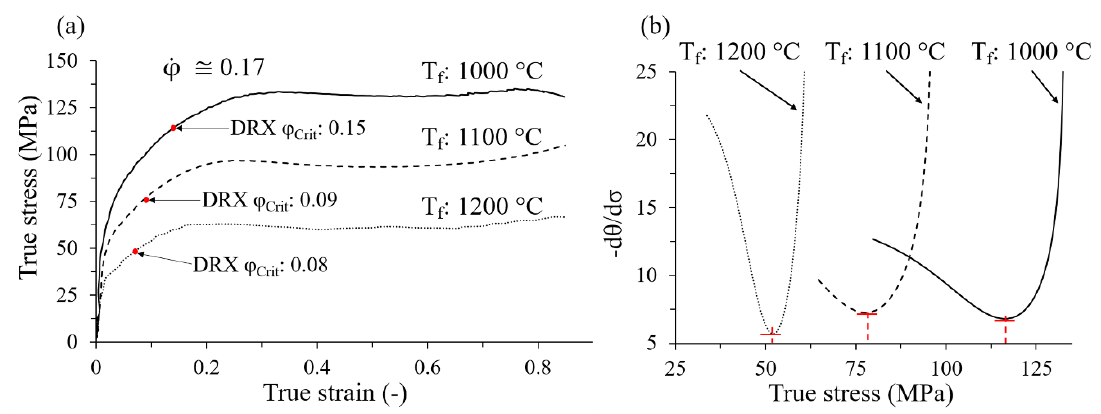
Figure 5. ( a ) Flow stress curves of the hot forging experiments with the critical strain for the onset of the DRX; and ( b ) − ( ∂ θ / ∂ σ ) versus σ curve, where the minimum value corresponds to the critical stress.